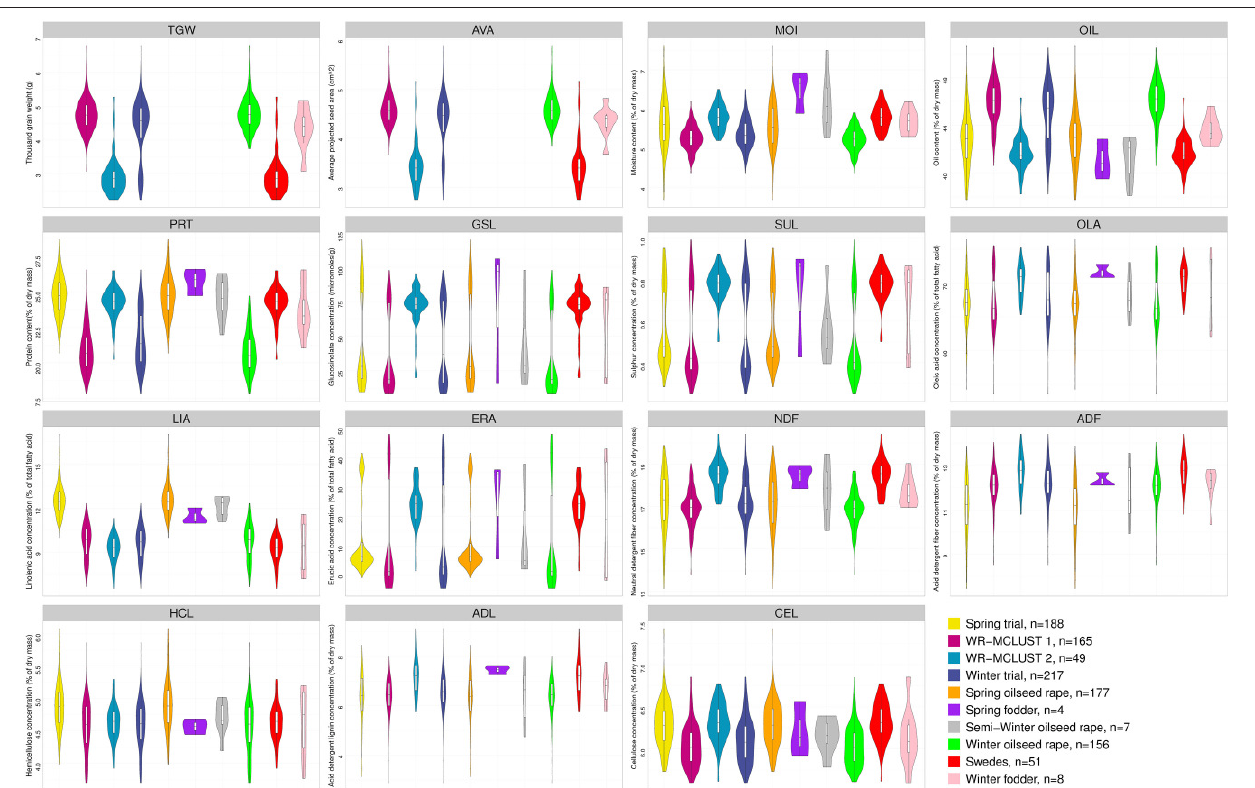
FIGURE 2 | Frequency distribution of adjusted entry means determined for 15 seed quality traits of the B. napus inbred lines for the spring and winter trial as well as the two WR-MCLUST groups and for six different germplasm types represented by different colors. Yellow plots represent the 188 inbreds of the spring trial and blue plots the 217 inbreds of the winter trial. The number of genotypes for each germplasm type is given in the legend. In each plot, a marker denotes the median of the data, a box indicates the interquartile range, and spikes extend to the upper and lower adjacent values, overlaid is the density.